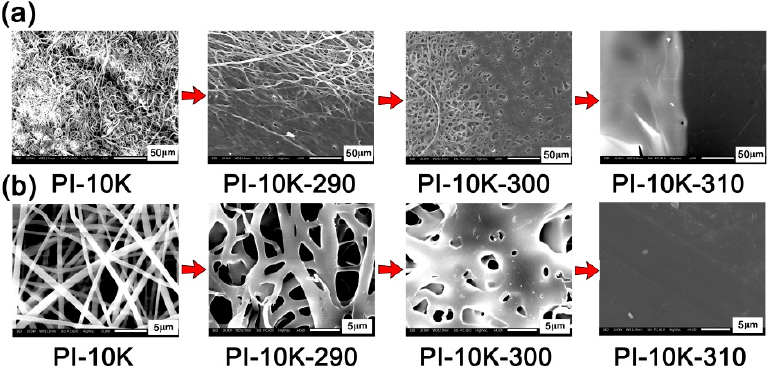
Figure 10. SEM images of electrospun PETI-10K nano-fibrous membranes at elevated temperatures. ( a ) ×500; ( b ) ×4500.